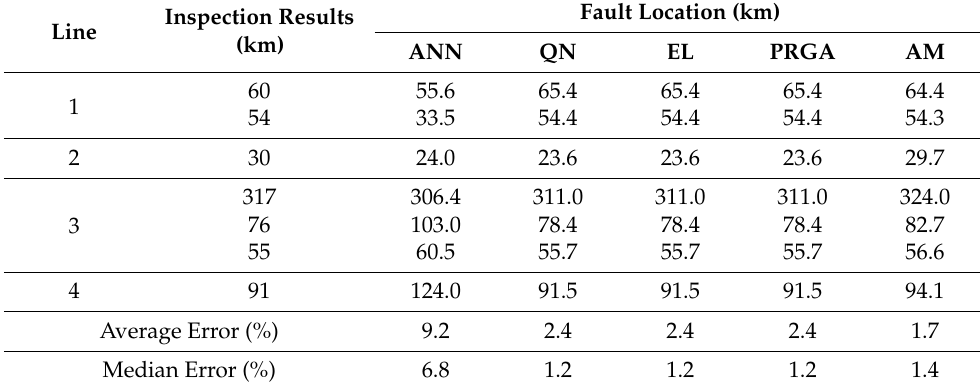
Table 12. Location results: real